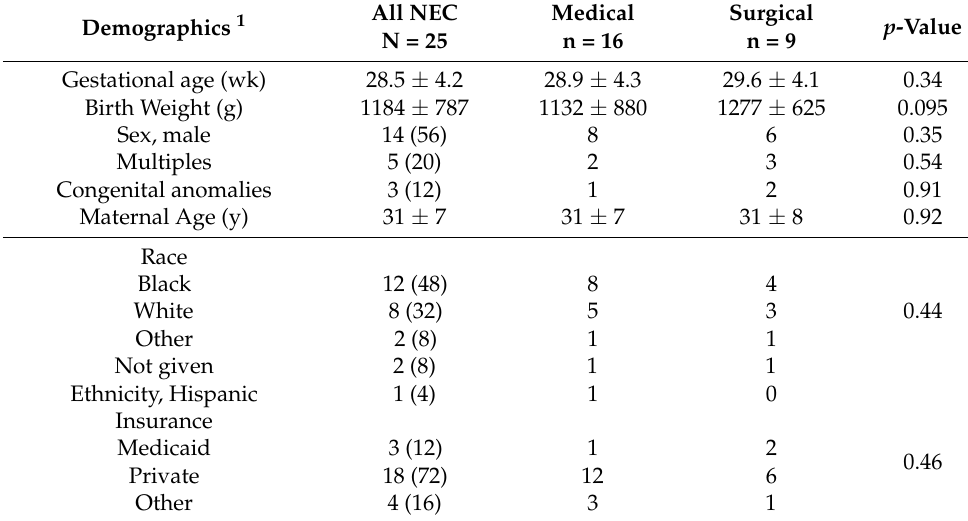
Table 1. Demographics by severity of necrotizing enterocolitis (NEC) .